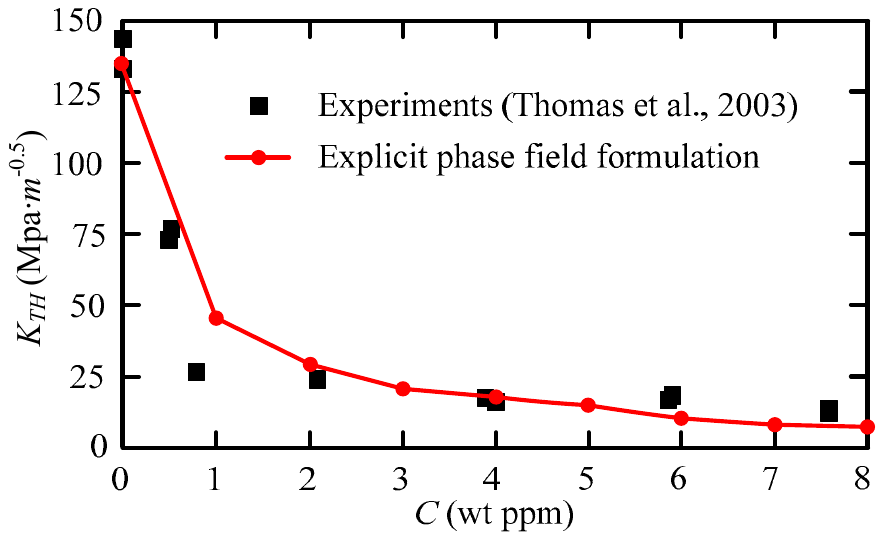
Figure 13. K TH as a function of the hydrogen concentration C in AerMet100 [40].